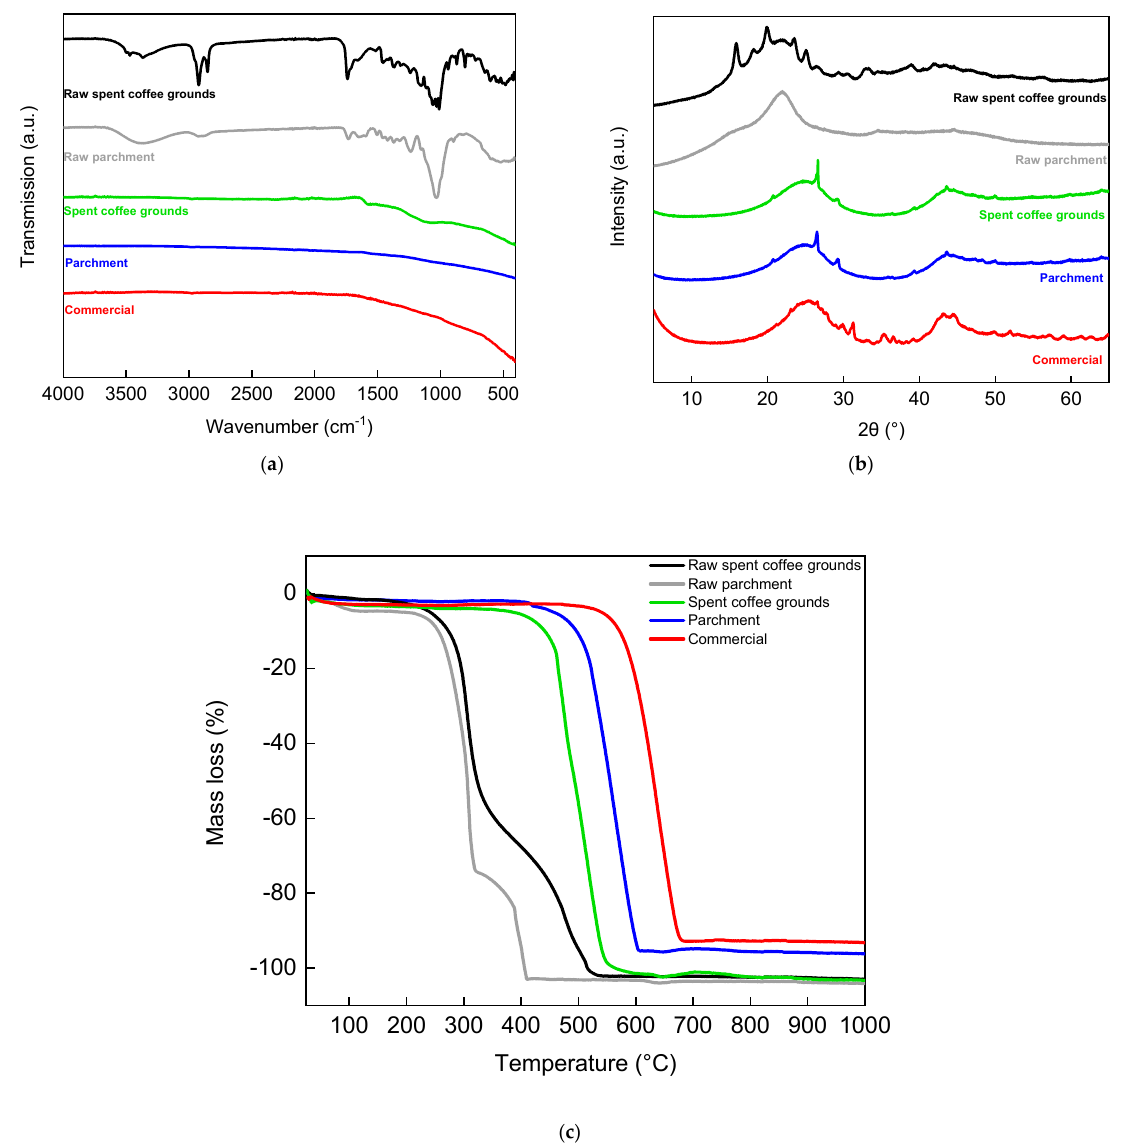
Figure 2. ( a ) IR spectra, ( b ) X ‐ ray diffraction patterns, and ( c ) TGA data of raw spent coffee grounds, raw parchment, spent coffee grounds, parchment, and commercial activated carbons. N 2 sorption measurements were performed to determine the specific surface area and porosity of the activated carbon materials, and the resulting isotherms are presented in Figure 3a. The adsorption branch of the isotherms of the activated carbon materials showed rapid N 2 uptake at low relative pressure (P/P 0 < 0.1), followed by a gradual uptake at higher relative pressures. Their sorption behavior indicates that these materials are largely microporous (IUPAC classification Type Ib) [58]. The activated carbon materials from parchment and spent coffee grounds exhibited open hysteresis, as seen from the non ‐ closing of the desorption branch at low P/P 0 . The resulting activated carbon from parch ‐ ment and spent coffee ground exhibited a BET specific surface area (SSA BET ) of 416 and 167 m 2 /g, respectively, while the commercial activated carbon had the highest SSA BET of 1010 m 2 /g (Table 1). The commercial activated carbon also had the highest pore volume of